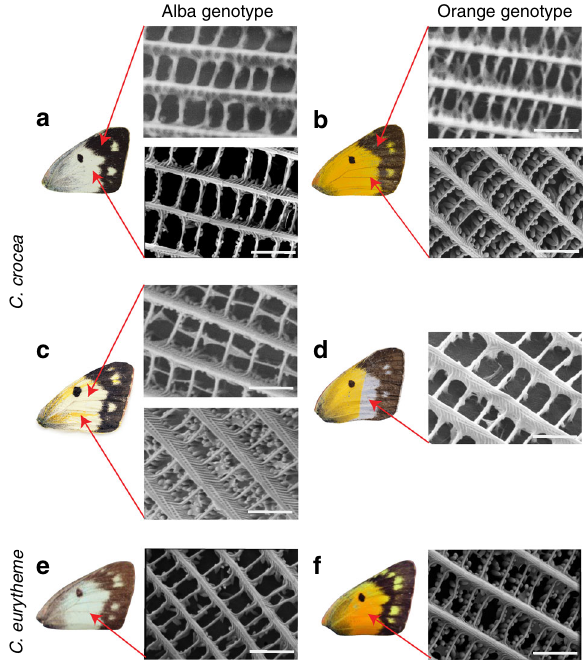
Fig. 3 Colias forewings and scanning electron microscopy of wing scale nanostructures. a C. crocea wild-type Alba female wing and wing scale structure. The top panel shows the scanning electron microscope (SEM) image of a black scale; pigment granules are absent. The bottom panel shows a white scale, exhibiting near absence of pigment granules. b Wing and wing scale structures of a wild-type orange C. crocea female. The top panel shows a black scale, pigment granules are absent. The bottom panel shows an orange scale with abundant pigment granules. c Wing and wing scales of a C. crocea female with an Alba genotype (i.e. transposable element insertion present) exhibiting CRISPR/Cas9 mosaic knockout of BarH-1 . The top panel shows a wild-type white scale, where pigment granules are mostly absent. The bottom panel shows a scale in an orange BarH-1 KO region. It exhibits signi fi cantly more pigment granules than the white scales (t 5.45 = 10.78, p < 0.001, Welch two sample t-test, n = 10 scales in a single mosaic individual). d Wing and wing scale of an orange C. crocea female where pigment granules have been chemically removed from the distal half of the wing. The SEM image shows a scale from the white region with pigment granules completely missing. The white color of this wing section presumably results from light re fl ection off the remaining scale nanostructures. e Wing and wing scale structure of a C. eurytheme Alba female. Wing scales exhibit few pigment granules, similar to the phenotype observed in C. crocea . f Wing and wing scale structures of a C. eurytheme orange female. Orange scales show abundant pigment granules, again consistent with the orange phenotype observed in C. crocea . All scale bars are 2 μ